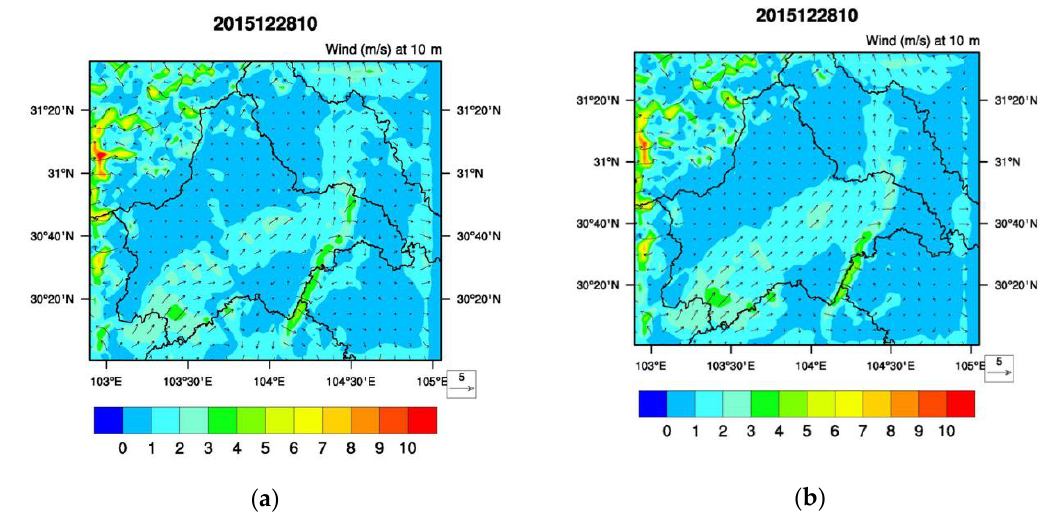
Figure 7. The 10-m wind speed map simulated using 1980 ( a ) and 2015 ( b ) land-use data (local time of 10:00 on December 28, 2015) .